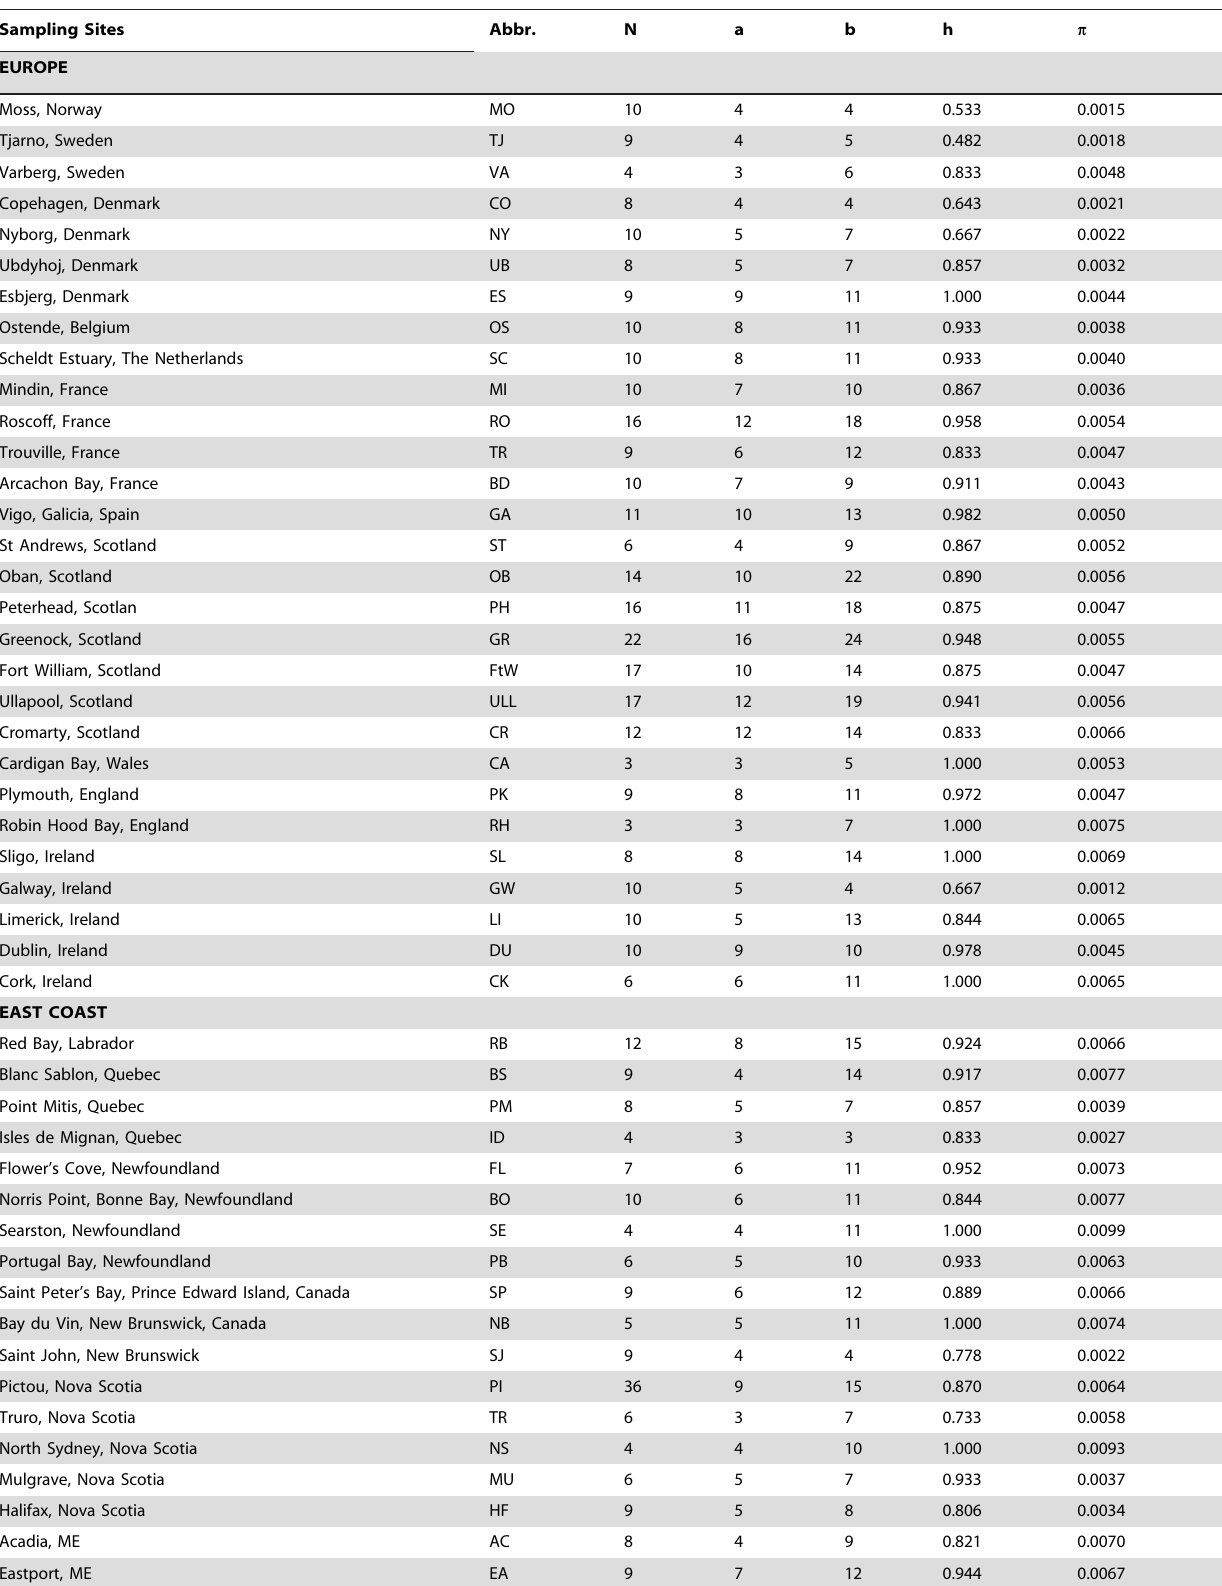
Table 2. Sampling region and sites, sample size (N) and measures of genetic diversity within sampled populations.